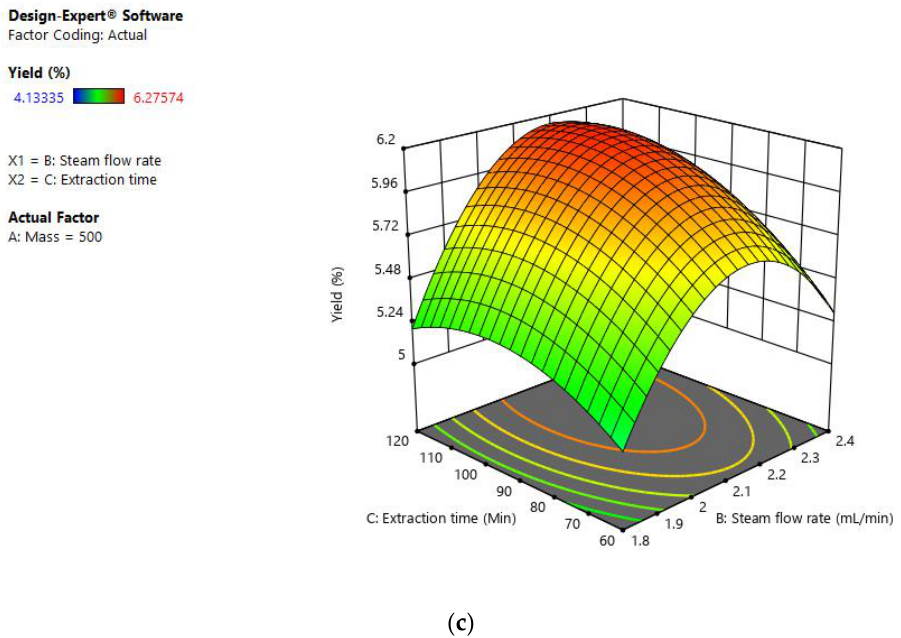
Figure 4. 3D diagram showing the effect of ( a ): AB, ( b ): (AC), ( c ): BC on the yield of essential oil. The influence of factors on the yield of essential oils is depicted by three-dimensional surface response plots, as shown in Figure 4. The red area of the graph represents the highest essential oil yield, whereas the blue area describes a lower result. The green to red color scale reveals the essential oil content values from 4.1334 to 6.2757%.